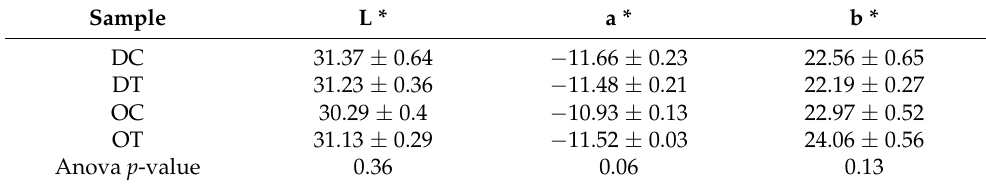
Table 7. The color parameters of wheat grass.